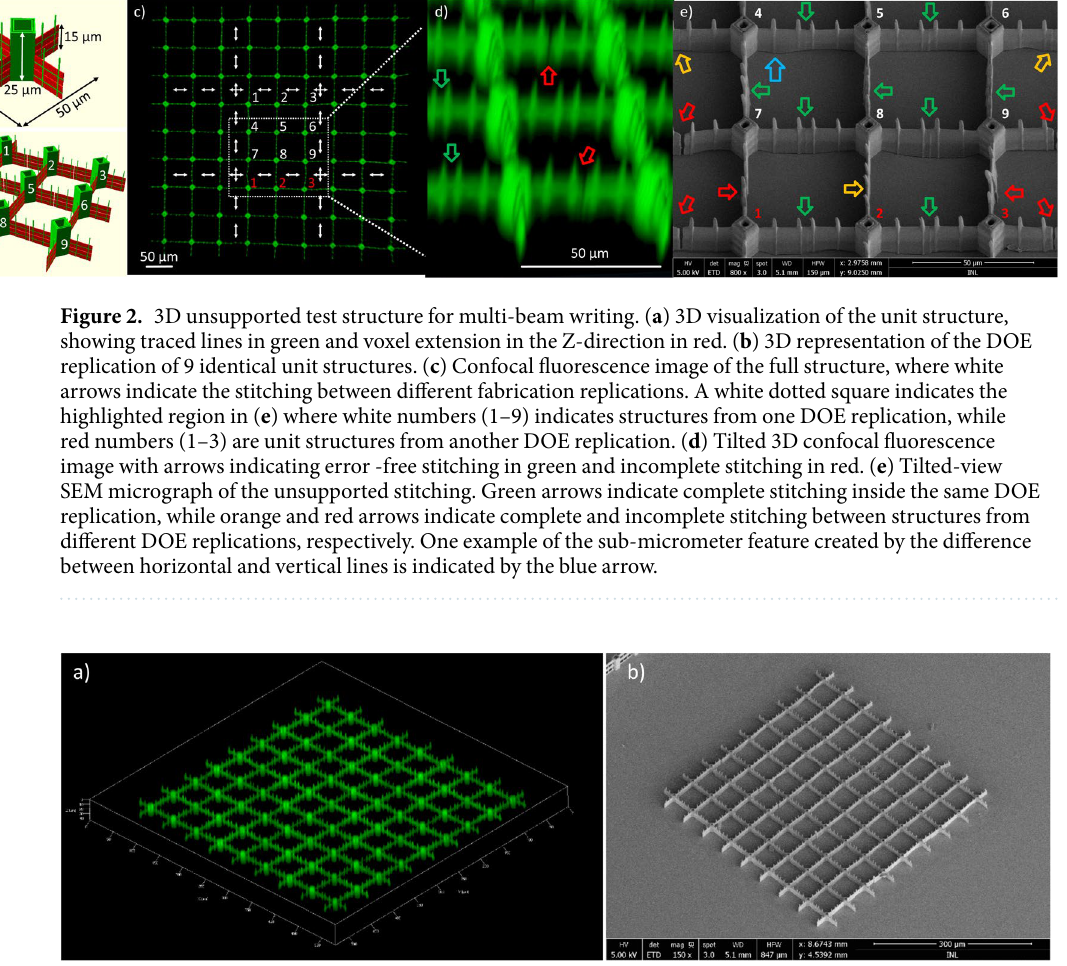
Figure 3. Array of unsupported stitched parallel fabricated unit structures. ( a ) Confocal fluorescence image of the full structure (20 × objective). ( b ) SEM micrograph of the full structure covering an area of 450 × 450 µ m, covered by a thin 10nm layer of gold. Fabrication time is 37 min for the full array where each individual unit structure takes 246